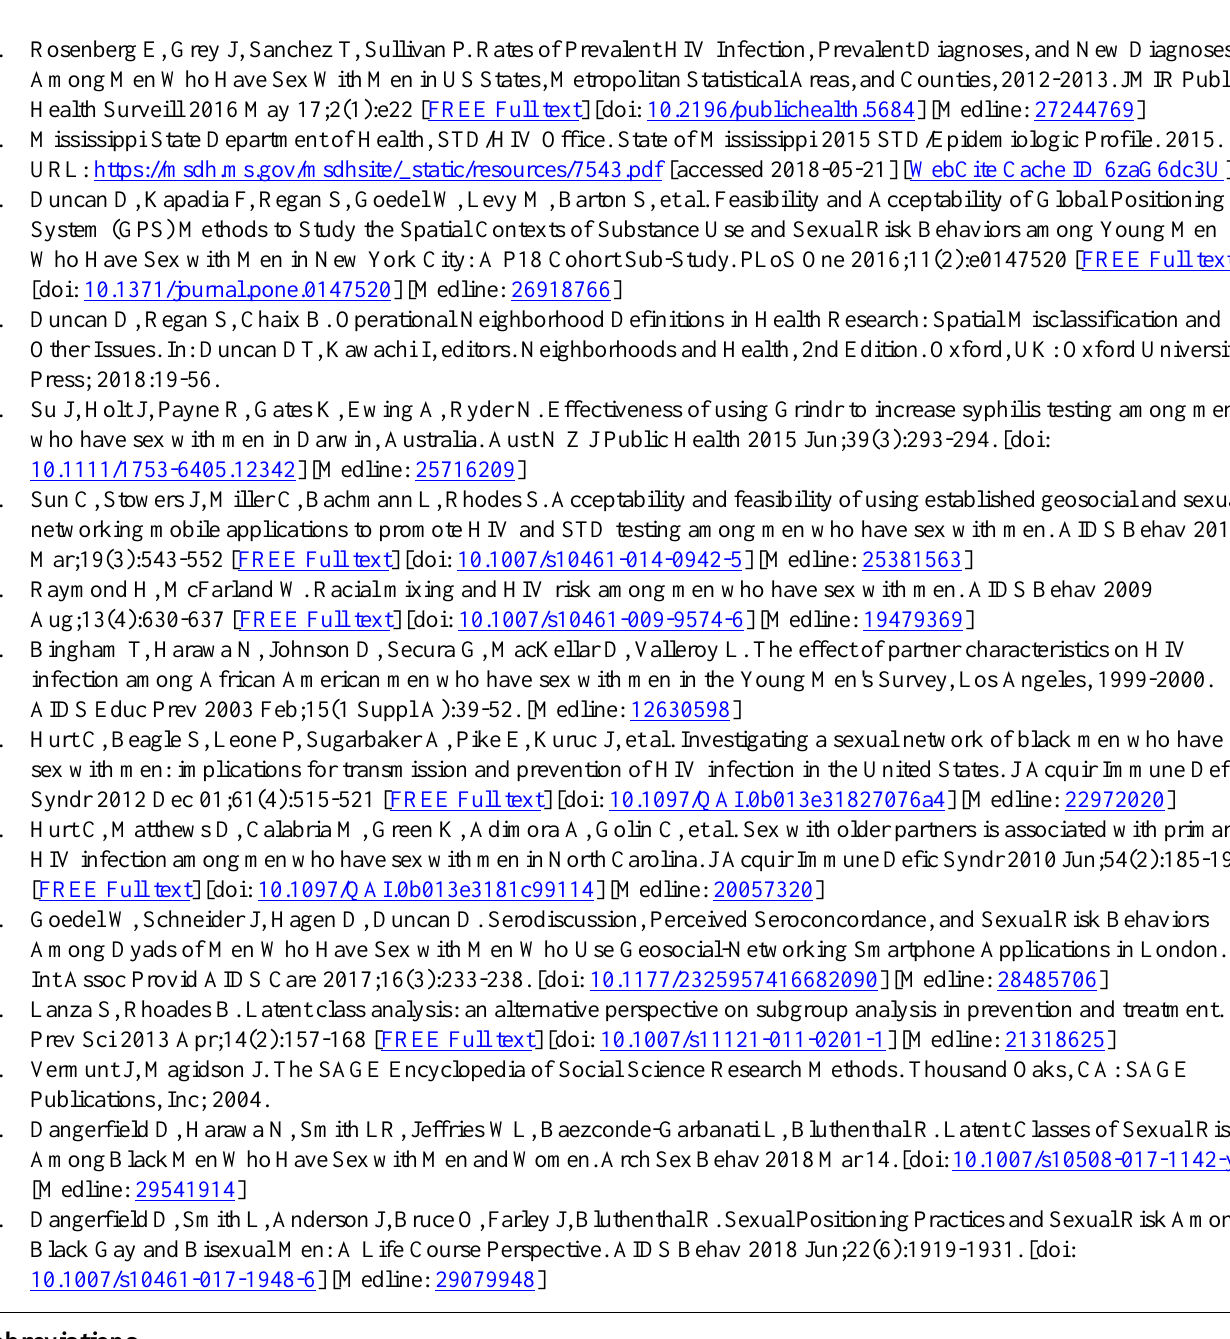
Abbreviations BMSM: black men who have sex with men CAI: condomless anal intercourse GSN: geosocial networking GPS: global positioning system HIV: human immunodeficiency virus IQR: interquartile range MSM: men who have sex with men PrEP: pre-exposure prophylaxis YBMSM: young black men who have sex with